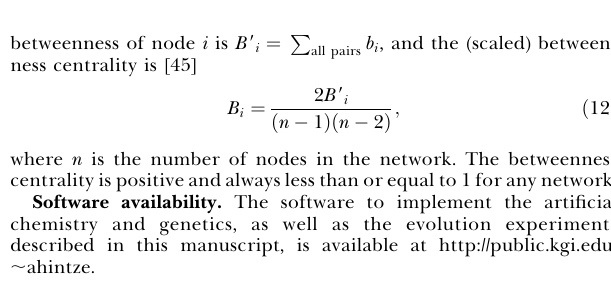
Figure S1. Distribution of Molecules in Reactions Probability distribution p ( k ) that a molecule participates in k reactions, compiled from 80 runs to depth 1,000 in a dynamic environment. The distribution is fit to a power law, with k ’ 2.23 ( r 2 ¼ 0.88). Error bars are standard error. Variable bin sizes are determined by the threshold binning method [37], with a minimum of T ¼ 100 points per bin. Figure S2. Evolution of Path Length Distribution Evolution of the distribution p ( d ), the probability to find two nodes in the network that are a distance d apart, for every 1,000th network on the line of descent, for a network evolved in a dynamic environment. Figure S3. Average Path Length D on the Line of Descent Mean path length D (see Methods) for a network with (A) metabolic,